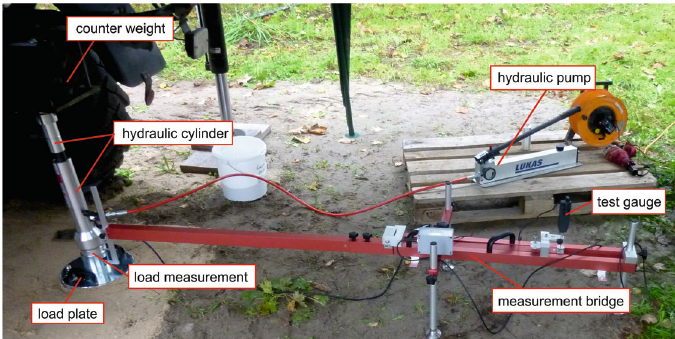
Figure 3. Experimental setup for a static plate load test